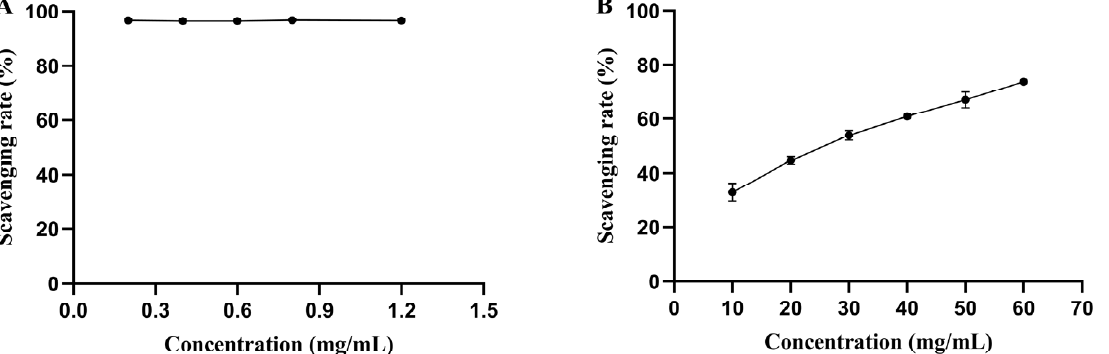
Figure 7. ( A ) The DPPH radical scavenging activity of ascorbic acid. ( B ) The DPPH radical scavenging activity of pePGA ‐ POS.